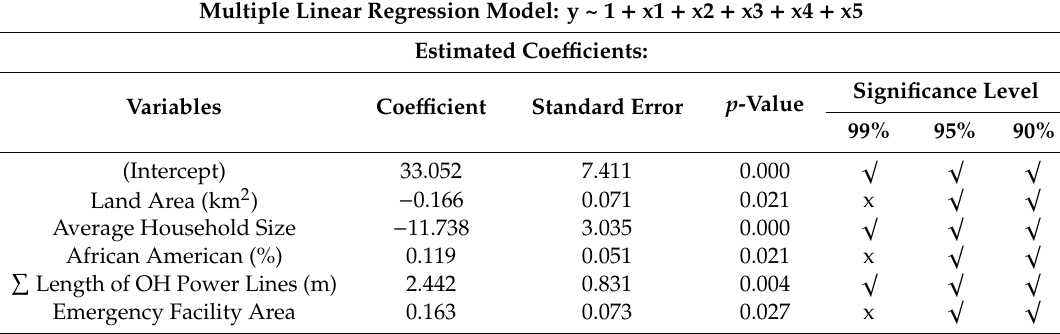
Table 4. Model results for Hurricane Hermine-induced roadway closures.